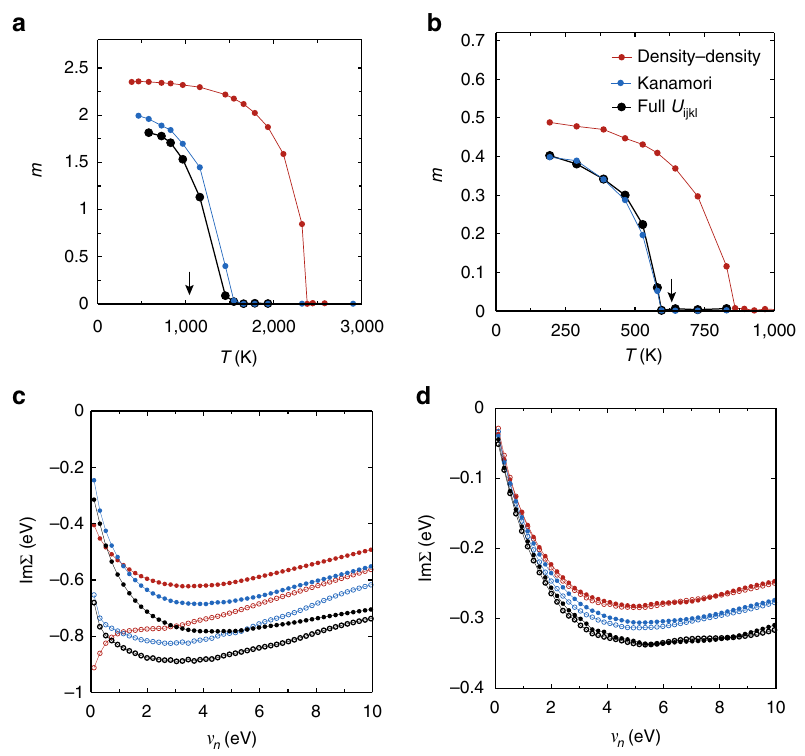
Figure 1 | Curie temperatures and self-energies of iron and nickel. Ferromagnetic order parameter m ¼ N " (cid:2) N # in bcc iron ( a ) and in fcc nickel ( b ) as a function of temperature, whereas N m ( N k ) are the total number of spin-up (-down) electrons in the correlated d orbitals. The Curie temperature T C is signalled by the magnetization dropping to zero. For nickel, we obtain T C ¼ 600K, very close to the experimental value of 633K (ref. 16), indicated by the black arrow in b . Our estimated T C for iron is around 1,500K, that is, roughly 30% larger than the experimental one of 1,043K (ref. 16), marked by the black arrow in a (for a discussion, see ‘Methods’ section, where also a description of the three parametrization used for the Coulomb interaction is given). Imaginary part of the Matsubara self-energies of iron ( c ) and nickel ( d ) at b ¼ 30eV (cid:2) 1 in the paramagnetic phase. The curves with filled circles show one of the degenerate t 2 g orbitals, with empty circles one of the degenerate e g orbitals. The lifetime of the quasiparticles is inversely proportional to Im (cid:2) ð i n n ! 0 Þ . Contrary to nickel, the scattering rate in iron at ambient pressure is large, even though the insulating-like shape of the density–density e g -self-energy is replaced by an upturn at small frequencies in Kanamori and full